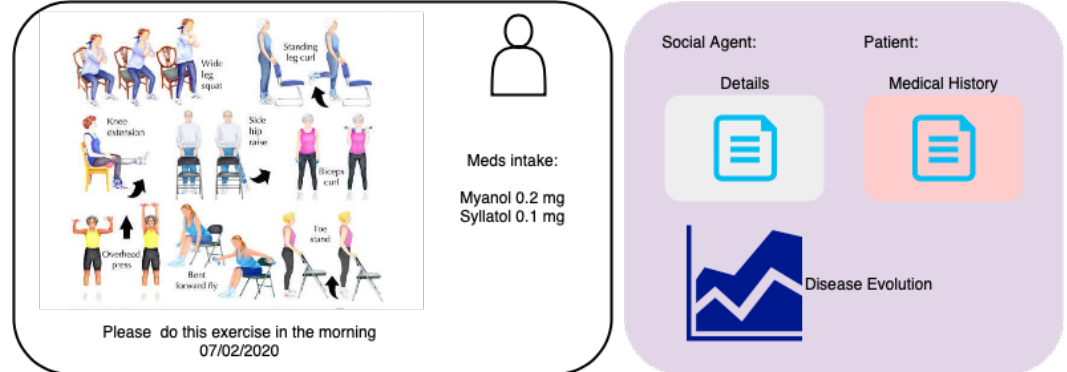
Figure 3. Particular case of a given user. Dashboard with information of task to be done by patient ( left ), and historical data about patient ( right